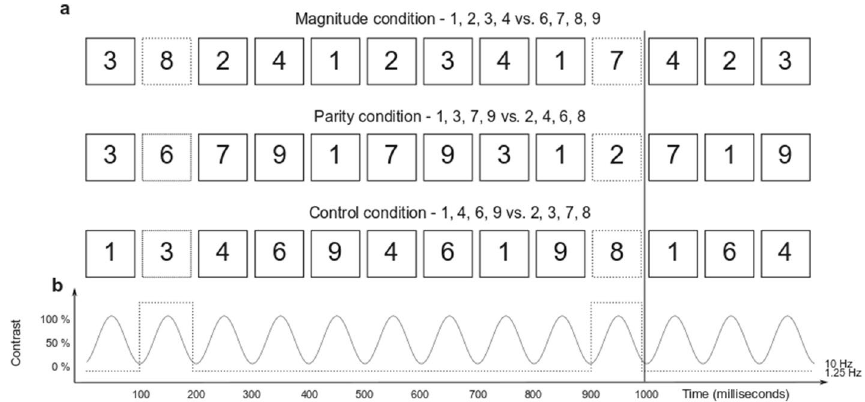
Figure 1. Illustration of the Fast Periodic Visual Stimulation paradigm. ( a ) During four 60 s sessions, Arabic digits between 1 and 9 (except 5) were periodically displayed at the base frequency of 10 Hz. In all conditions, digits from a determined standard category were periodically displayed at the base frequency, while digits from another deviant category were displayed at the oddball frequency of 1.25 Hz. In the Magnitude condition, categories were based on the magnitude of the digits (smaller or larger than five). In the Parity condition, categories were constructed as a function of the parity of the Arabic digit (odd or even). In the Control condition, categories were arbitrary. Fonts, font sizes, and positions are here constant for better readability. ( b ) Illustration of the onset and the offset of each stimulus following the sinusoidal contrast modulation from a 0 to 100%